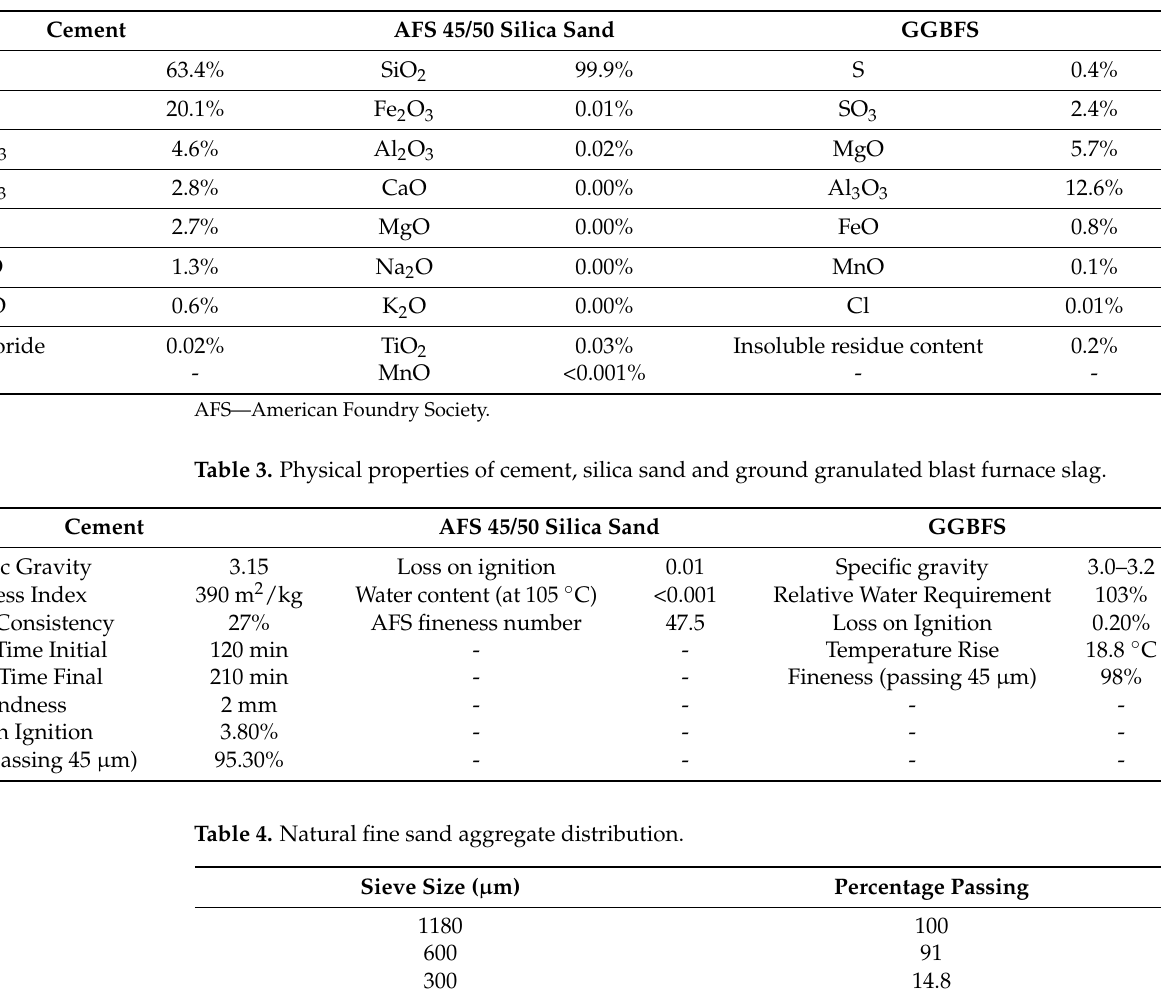
Table 2. Chemical composition of cement, silica sand and ground granulated blast furnace slag (major components listed).